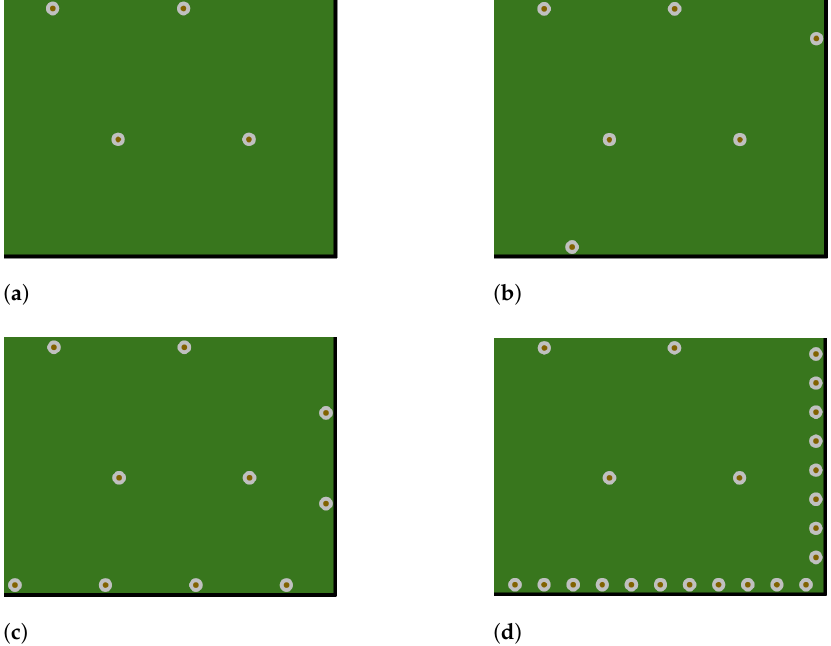
Figure 5. Variations in via fencing density around the perimeter of the PCB: ( a ) no via fence, ( b ) 400mil via spacing, ( c ) 100mil via spacing, and ( d ) 20mil via spacing. Images show the corner of each PCB design for easy comparison. Note that in all cases, via stitching is present internal to the board to tie all ground layers together.